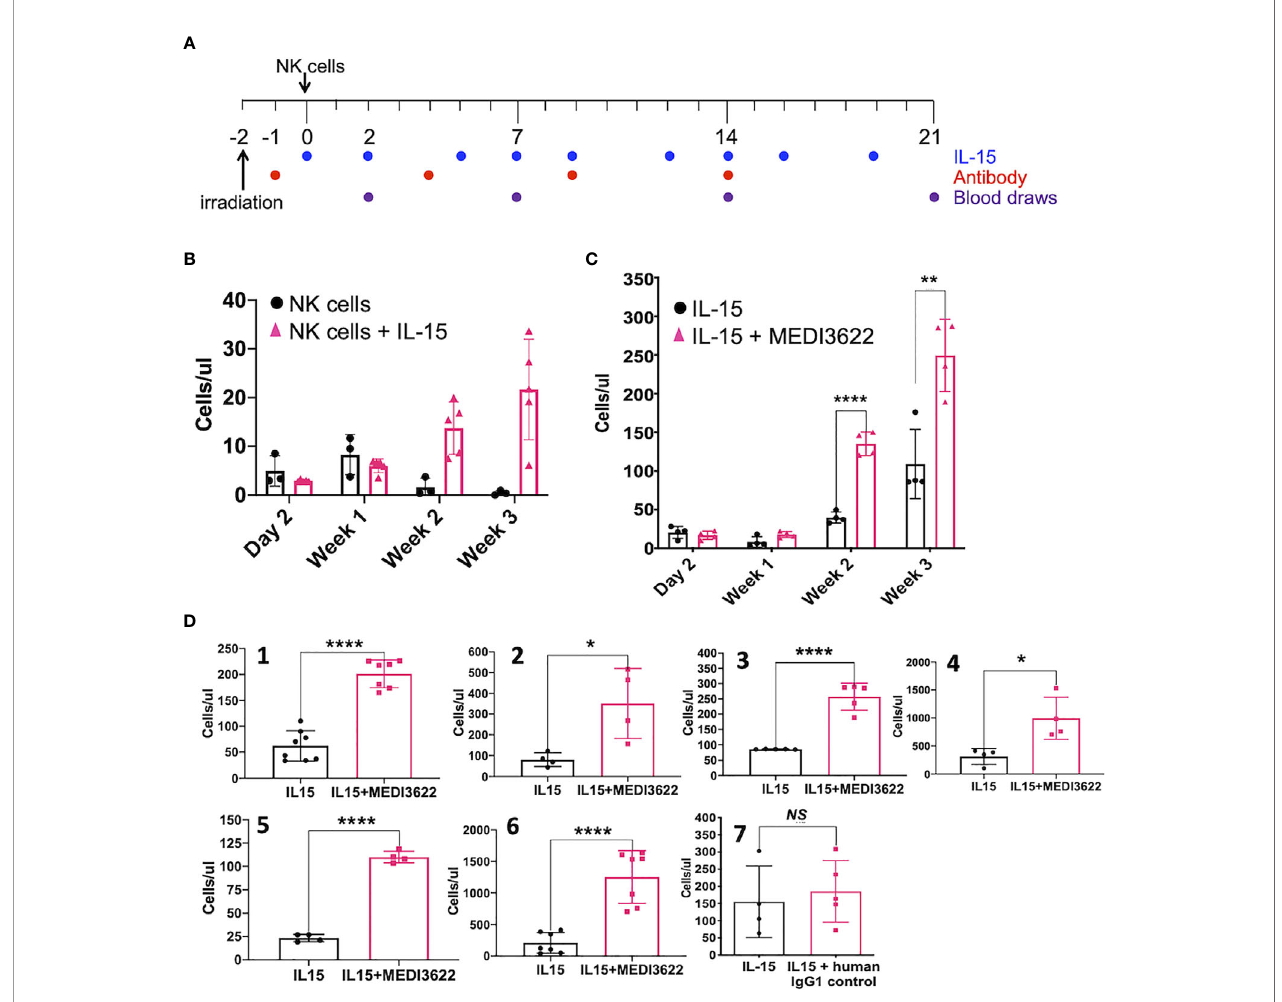
FIGURE 2 | ADAM17 blockade enhances human NK cell proliferation by IL-15 in vivo. (A) Animal treatment schema. NSG mice were treated as described in the Methods. (B) Enriched NK cells were infused in the presence or absence of rhIL-15 (5 m g), as indicated. Mouse peripheral blood was collected and the number of human CD45 + CD56 + CD3 − NK cells were enumerated by fl ow cytometry and are shown as cells/ m l. Data are mean ± SD (n = 3 to 5 mice per group). (C) Additional mice were administered enriched NK cells from a separate donor plus rhIL-15 (5 m g) ± MEDI3622 (10 mg/kg). Data are mean ± SD (n = 4 mice per group). **p < 0.01; ****p < 0.0001. (D) The experiment was performed as described in panel (C) NK cells were obtained from six separate donors (panels 1-6). Mice were also treated with rhIL-15 in the presence or absence of a human IgG1 control mAb (panel 7). Mouse peripheral blood was collected at day 21 following NK cell adoptive transfer and human CD45 + CD56 + CD3 − NK cells were enumerated by fl ow cytometry. Group data was tested for normality (Kolmogorov-Smirnov test) and the differences in means were calculated by comparing means ± SD using an unpaired two-sided Student ’ s t-test. n = 3 to 7 mice per group. *p < 0.05; **p < 0.01; ****p < 0.0001; ns, not signi fi